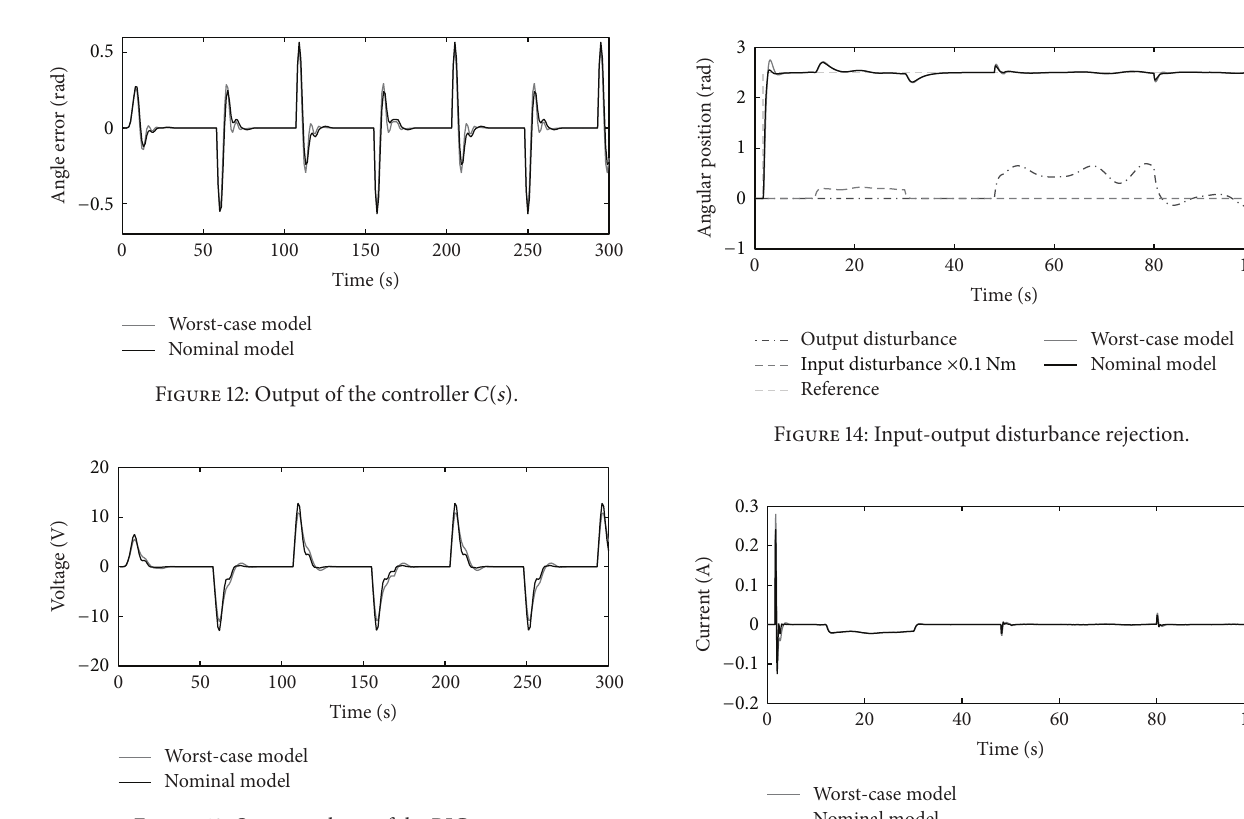
Figure 13: Output-voltage of the RIC system.